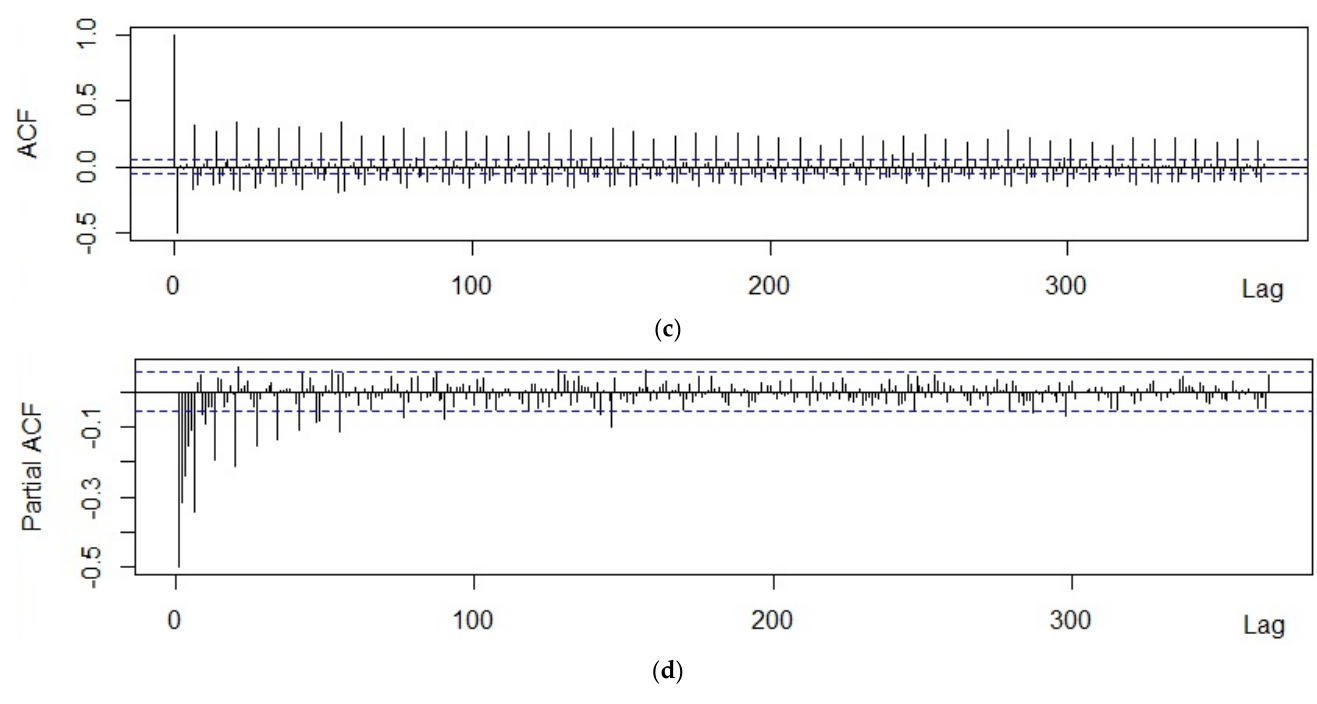
Figure A6. Autocorrelation function (ACF) of the Moran’s I b for Butter prices of the original time series ( a ) and of the first differences ( c ); Partial autocorrelation function (PACF) of the Moran’s I b for Butter prices of the original time series ( b ) and of the first differences ( d ). The Moran’s I b indexes are calculated based on binary contiguity matrices.